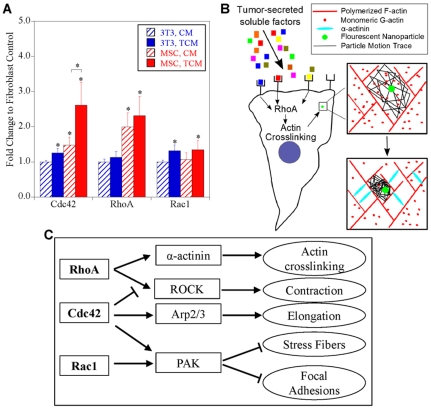
Alterations in Gene Expression.Changes in expression of small Rho GTPases RhoA, Rac1, and Cdc42 before and after prolonged treatment with TCM (A). A simplified diagram of short-term response of cells to treatment with TCM by actin polymerization and crosslinking (B). After 24 hour exposure to TCM, alterations in morphology and adhesion can be explained by differential gene expression in MSCs and fibroblasts (C).